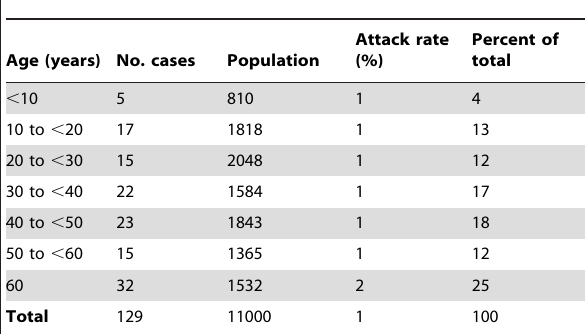
Table 3. Age distribution for confirmed cases during the CHIK fever outbreak in the Xincun